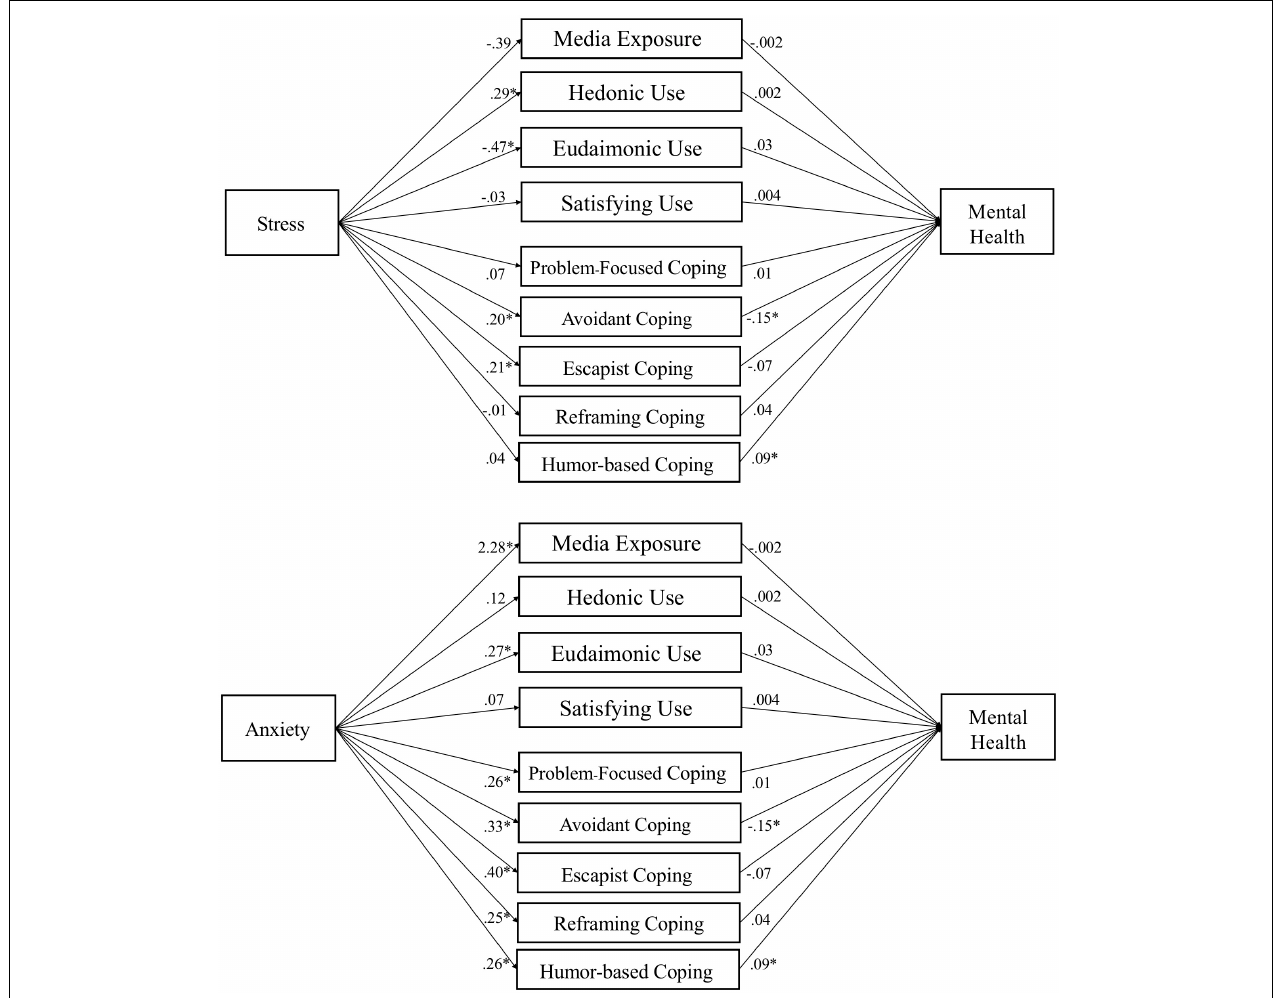
FIGURE 3 | Media use partially mediates influence of stress and anxiety on mental health. Note. Parallel mediation of media motives on mental health. Gender, age, ethnicity, race, level of education, and traits (hope, optimism, and resilience) are used as covariates in PROCESS Model 4 using 10,000 bootstrap samples. Path coefficients reported are unstandardized, p < .05 denoted with an *. Indirect effects appear in text and Table 7